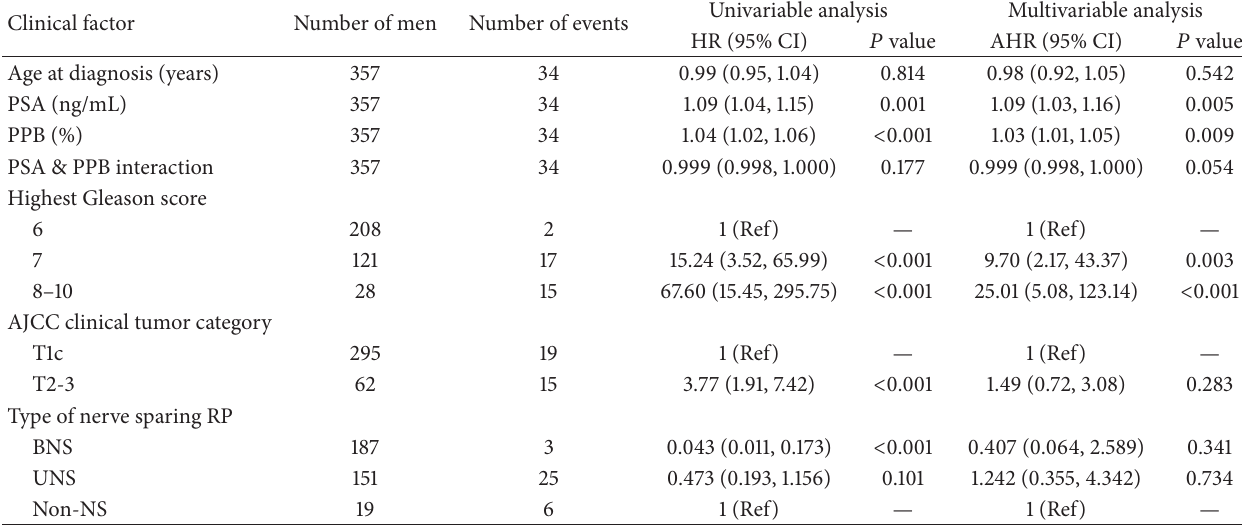
Table 2: Univariable and Multivariable hazard ratios for clinical factors from the Cox regression analysis for the risk of PSA-failure. Clinical factor